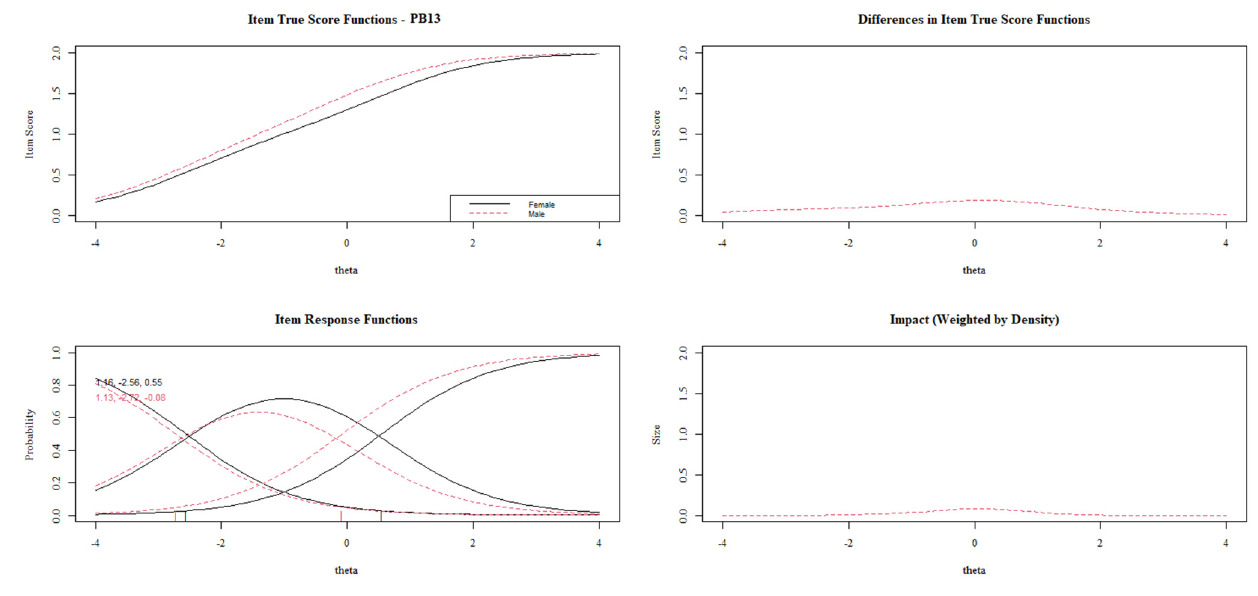
Figure 6. DIF plots for item PB13.